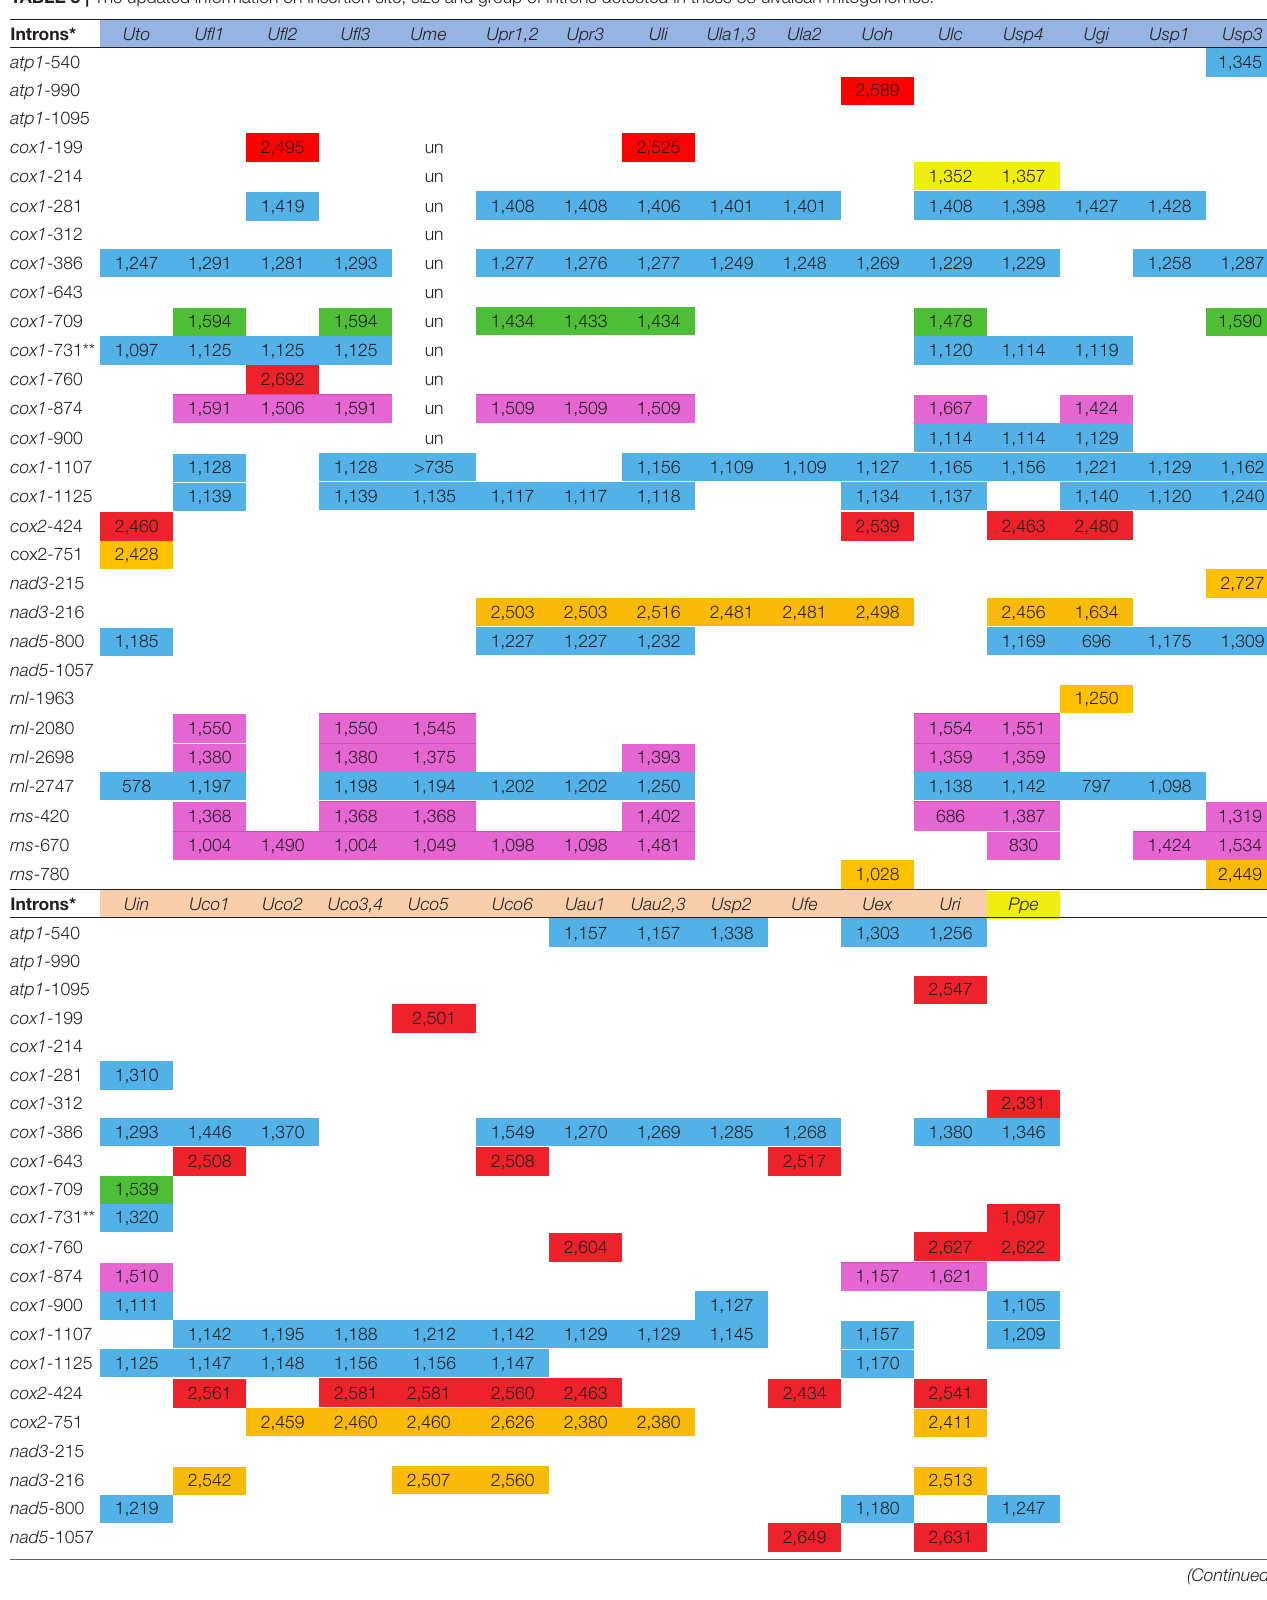
TABLE 3 | The updated information on insertion site, size and group of introns detected in these 33 ulvalean mitogenomes.